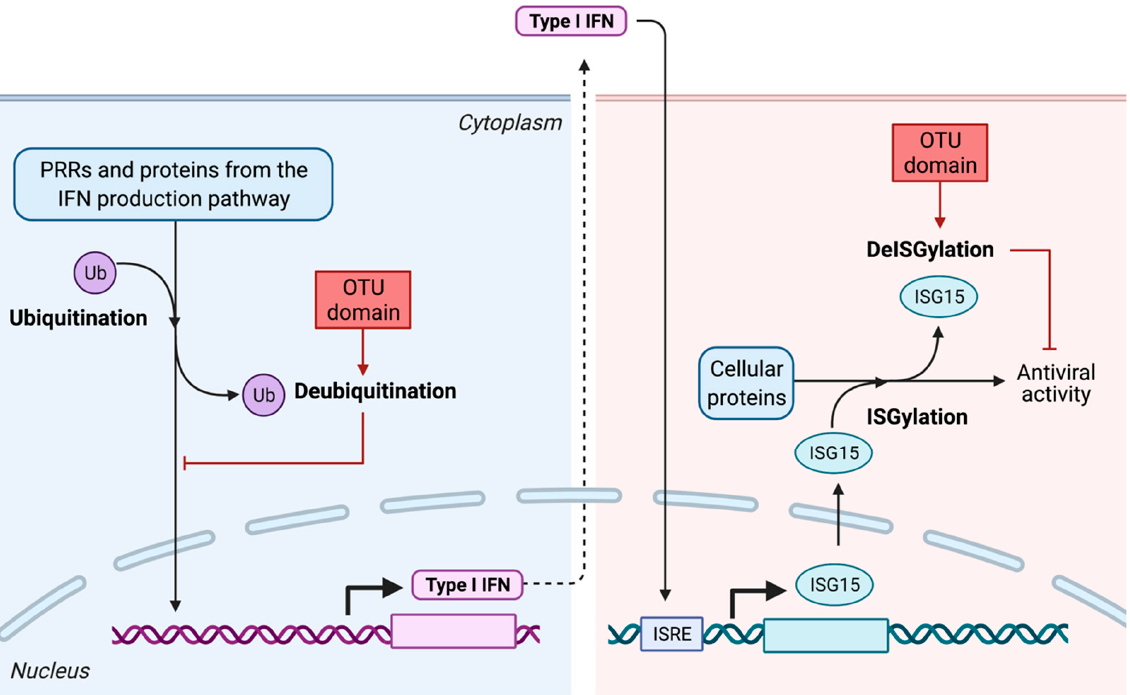
Figure 4. Deubiquitination and deISGylation activity of the nairovirus OTU domain. IFN: interferon; ISG15: IFN-stimulated gene 15; ISRE: IFN-stimulated response element; OTU domain: ovarian tumor domain; Ub: ubiquitin.